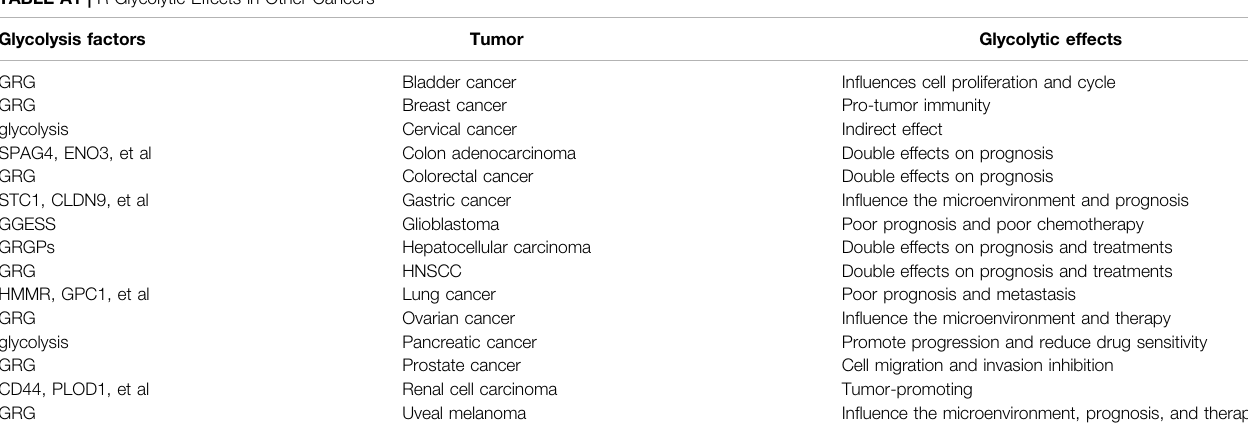
TABLE A1 | R Glycolytic Effects in Other Cancers Glycolysis